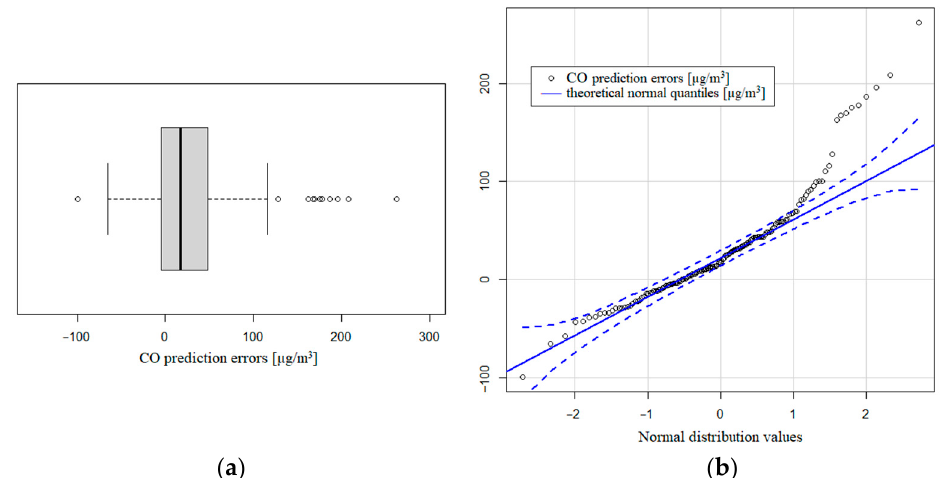
Figure 9. ( a ) Boxplot of CO prediction errors; ( b ) theoretical normal quantiles compared to prediction errors.